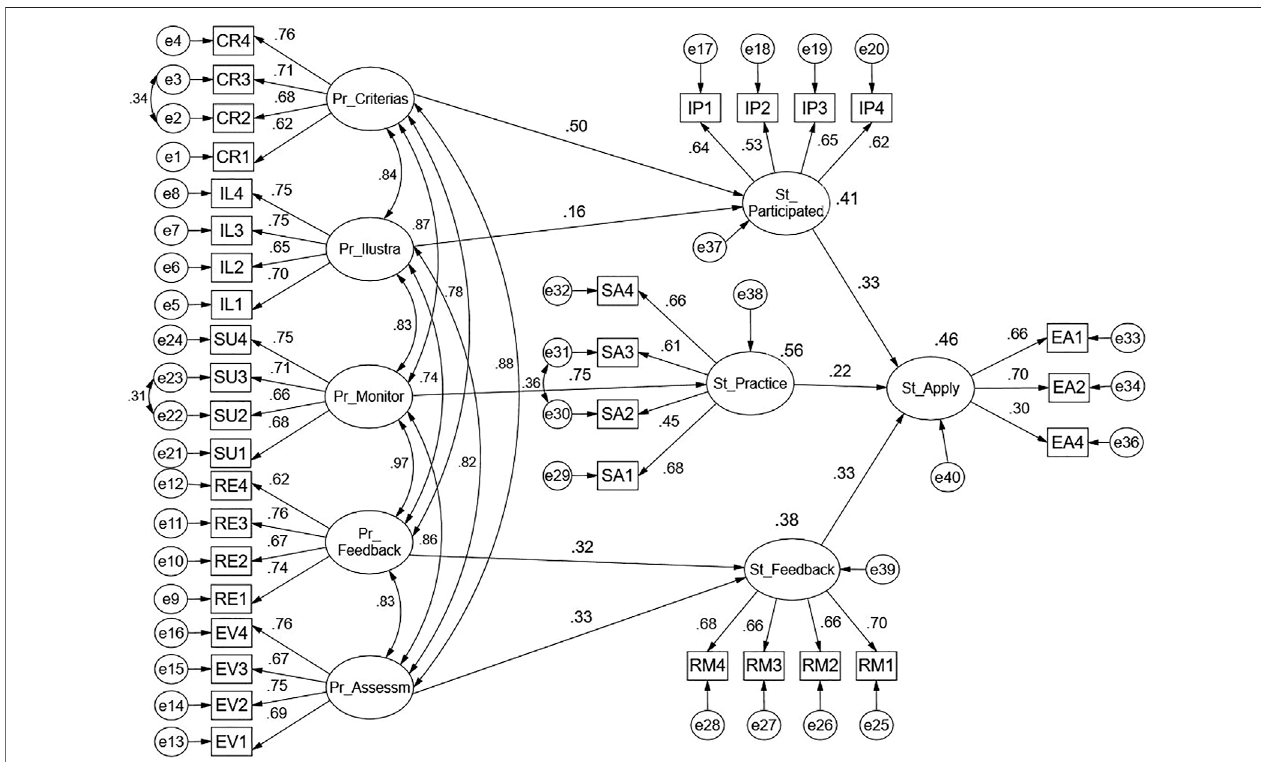
FIGURE2| Structuralregressionmodelontheeffectsoftheteachingperformancecriteriaonthedidacticperformancesofpostgraduatestudents.Note.Teaching performance variables: Pr_Criterias = criteria explicitness, Pr_Ilustra = illustration, Pr_Monitor = supervision – monitoring, Pr_Feedback = feedback, and Pr_Assessm